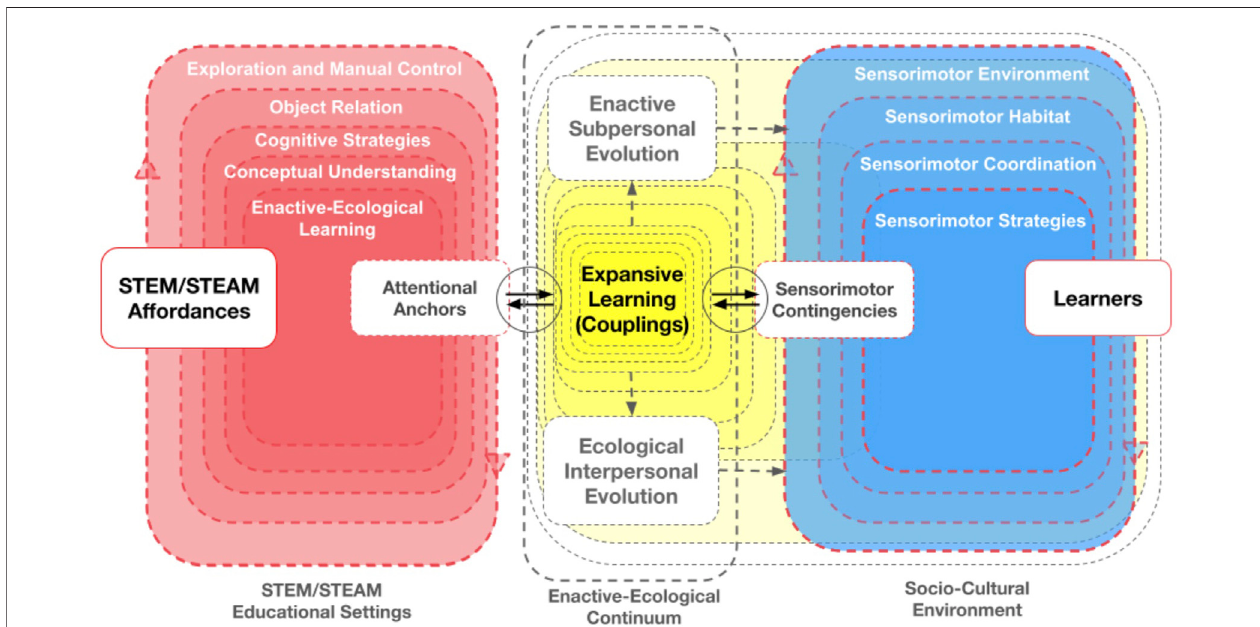
FIGURE 2 | The enactive-ecological continuum model for STEM/STEAM pedagogy, where the expansive learning process occurs as an ongoing set of structural couplings between the shared inter-action between learners (de fi ned by the socio-cultural environment and historicity of individual enactive and collective ecological evolution) and STEM/STEAM affordances, through sensorimotor contingencies and attentional anchors.